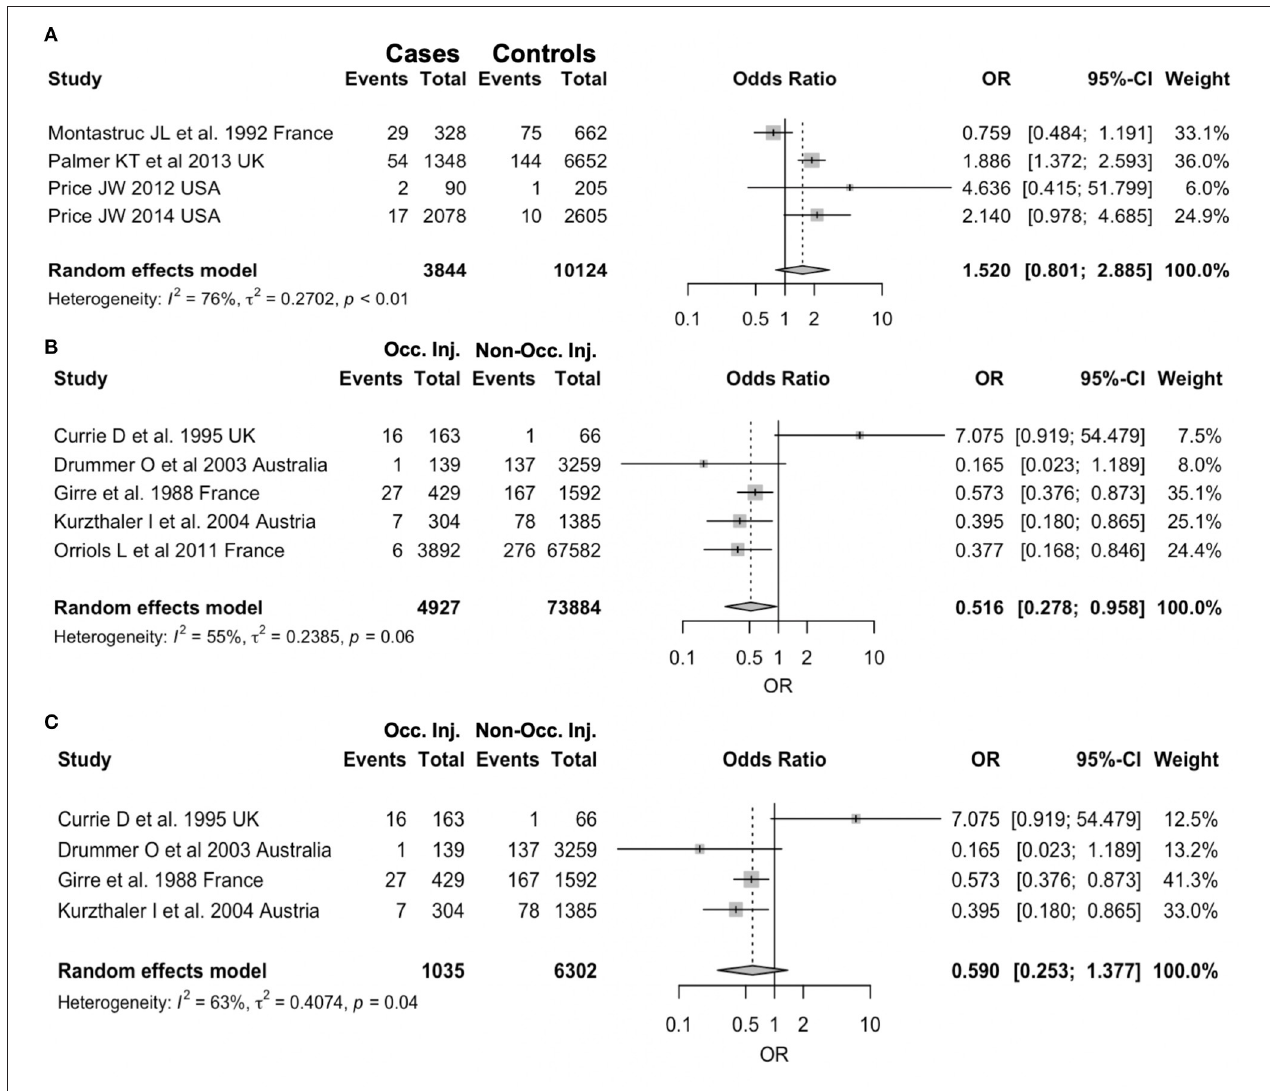
FIGURE 3 | Forest plots for study specific Odds Ratios (OR) with their correspondent 95% confidence intervals (CI) stratified by study design. (A) Case-Control studies: positive cases among injured workers vs. positive controls from general population. (B) Cross sectional studies: positive cases in occupational injuries vs. non-occupational injuries. (C) Cross sectional studies: only laboratory-based